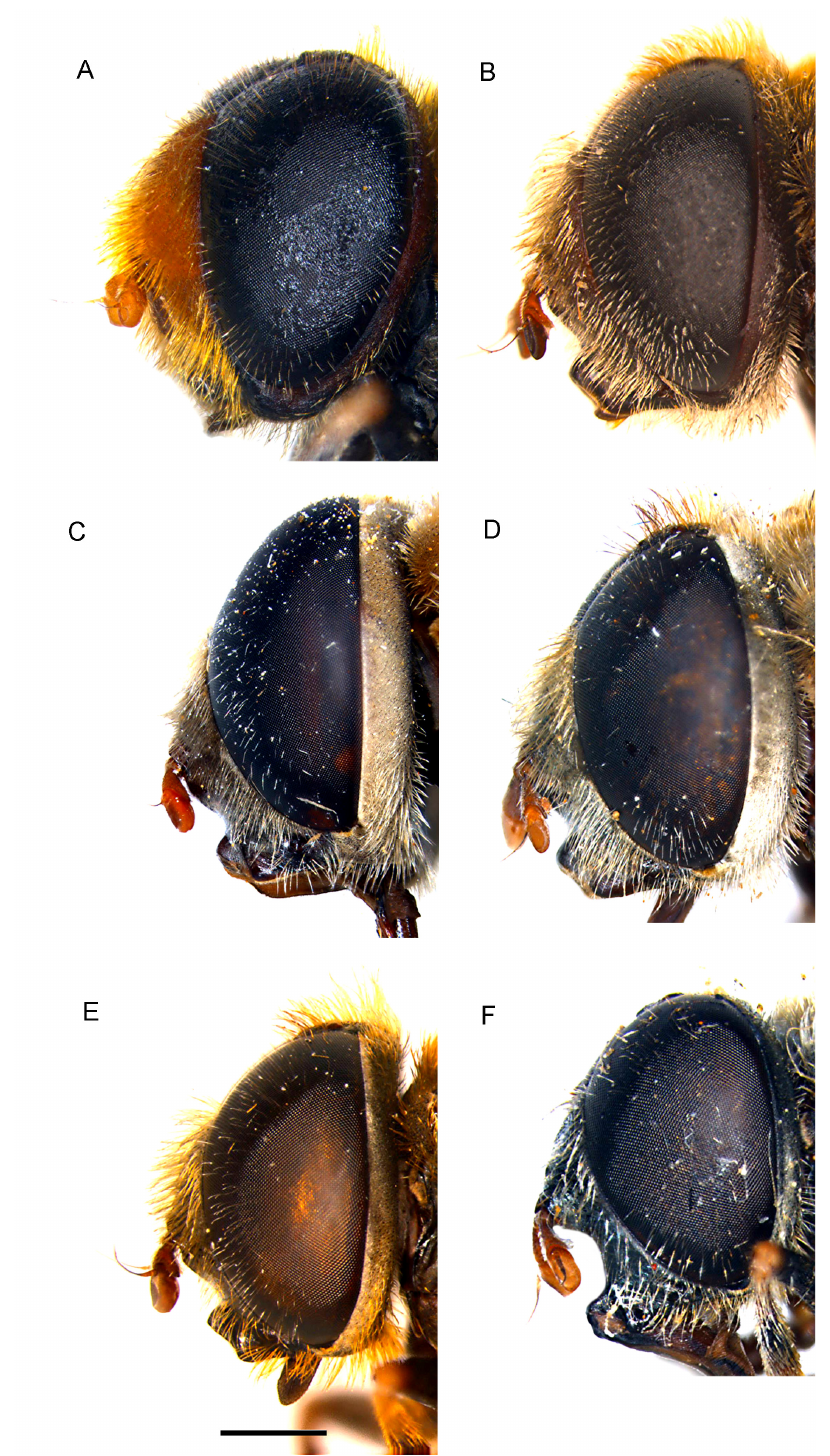
Fig. 9. Male head, lateral view. A . Merodon bombiformis Hull, 1944 (FSUNS; FSUNS ZA2_079). B . M. multifasciatus Curran, 1939 (USNM 2052372; FSUNS ID 04512). C . M. vittatus Vujić & Likov sp. nov., holotype (NBCN; FSUNS ID 04085). D . M. zebra Vujić & Radenković sp. nov., holotype (RMCA; FSUNS ID 25089). E . M. lotus Vujić & Radenković sp. nov., paratype (FSUNS; FSUNS ID ZA6_066). F . M. nasicus Bezzi, 1915 (TAUI; FSUNS ID 04972). Scale bar = 2